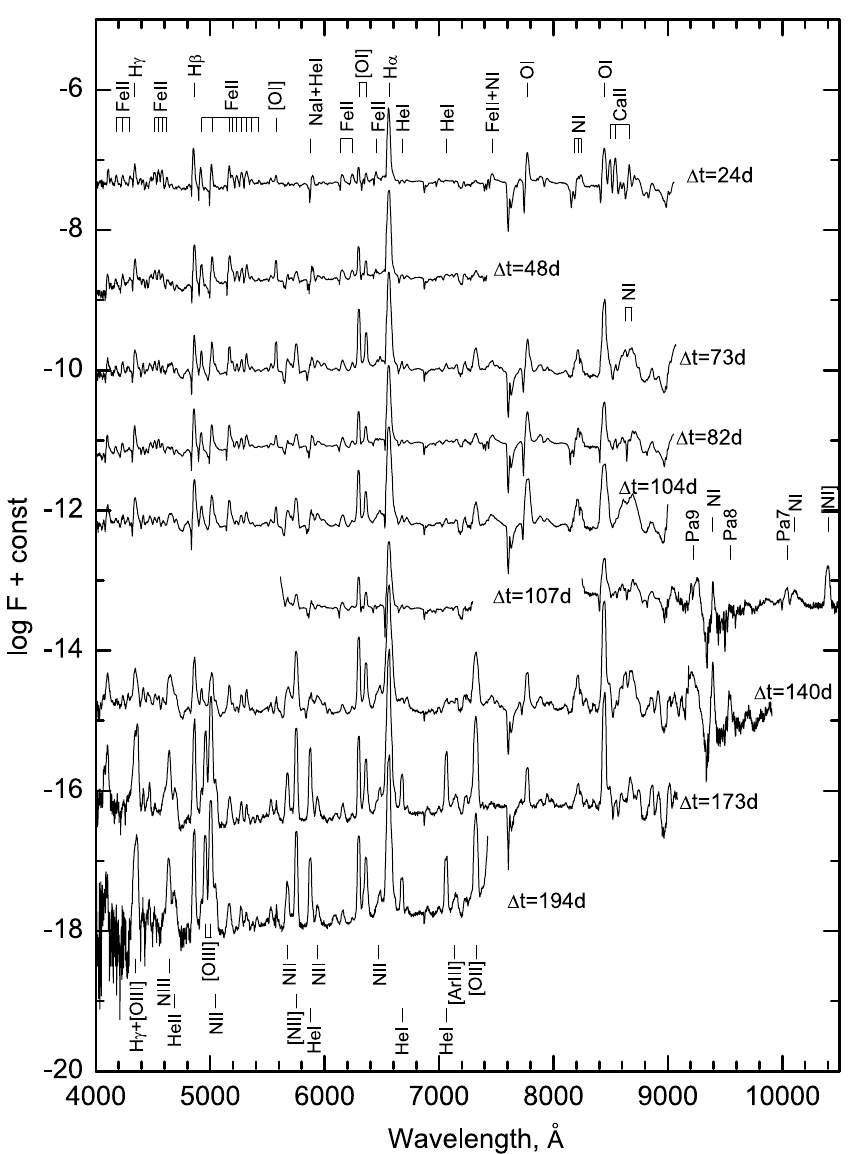
Fig. 3. Spectral evolution of V2659 Cyg. For clarity, individual spectra were moved along the ordinate. have pointed out a variation in excitation conditions. The absorption component strengthening at light maxima is considered to indicate an increase in the density and in the mass-loss rate in the form of a wind. Williams (2012) attributes this behavior at secondary maxima not to the growth of effective temperature but to the increase in photospheric radius that is due to a variable